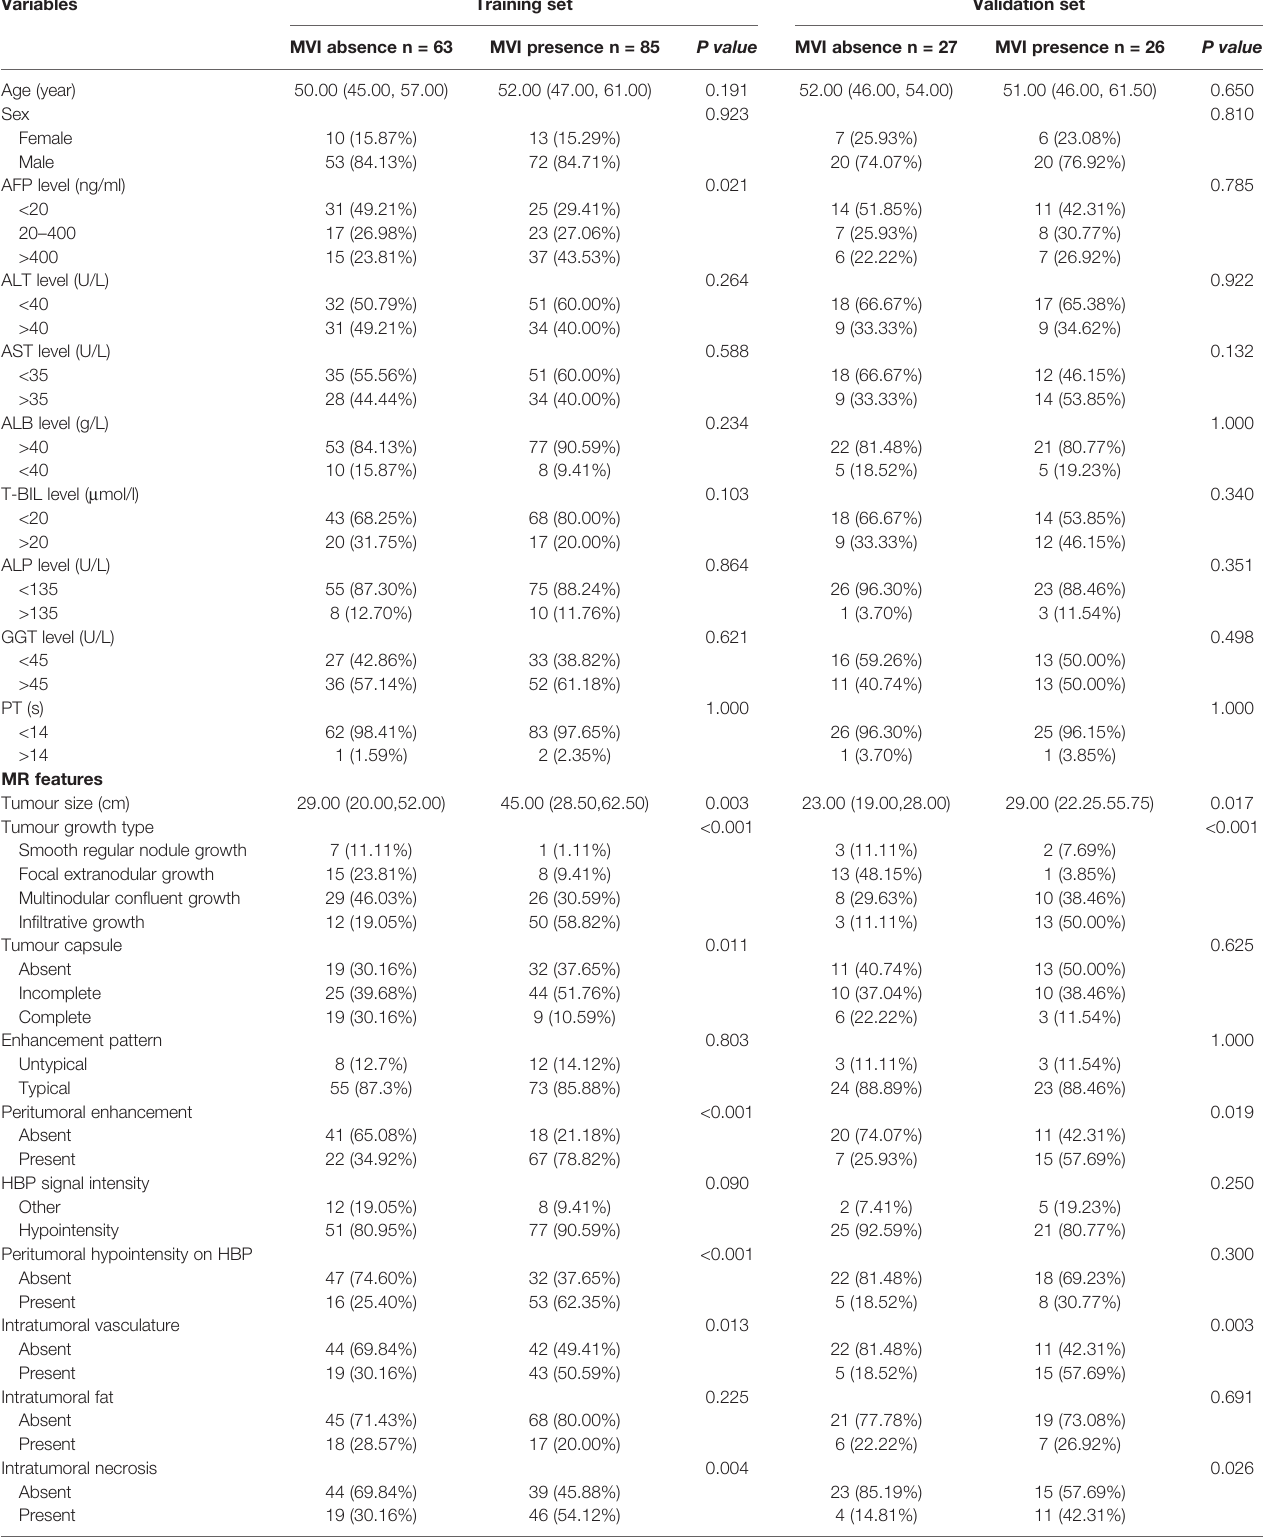
TABLE 1 | Patient characteristics in the training and validation